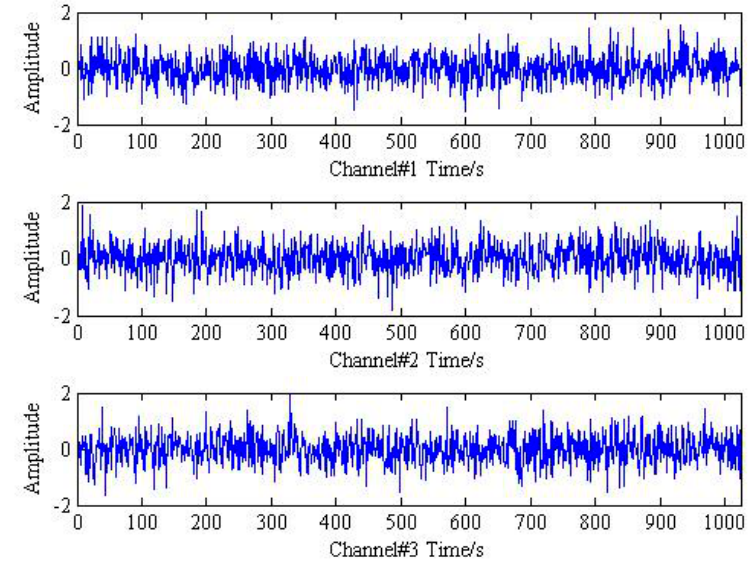
Figure 1. The time response of mixed trivariate signal with noise.